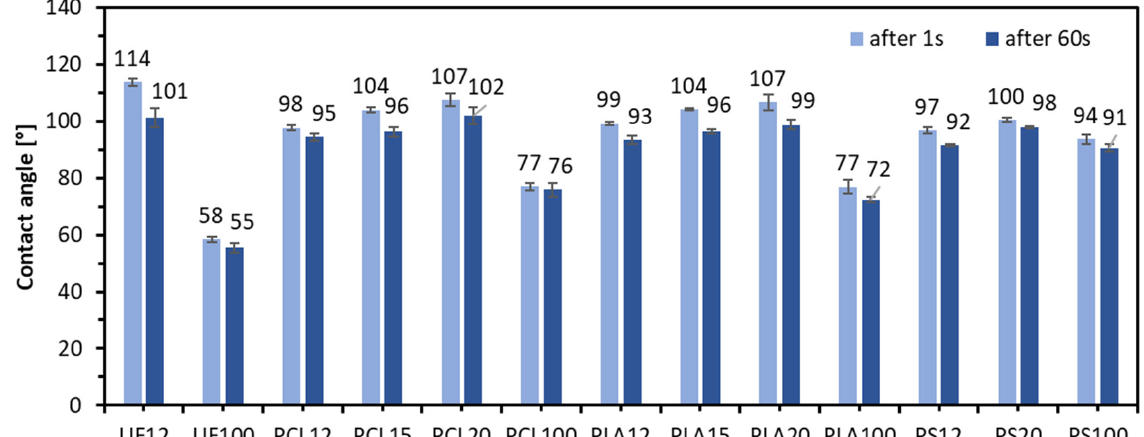
Figure 8. The contact angle of tested lignocellulosic composites and pure binders.